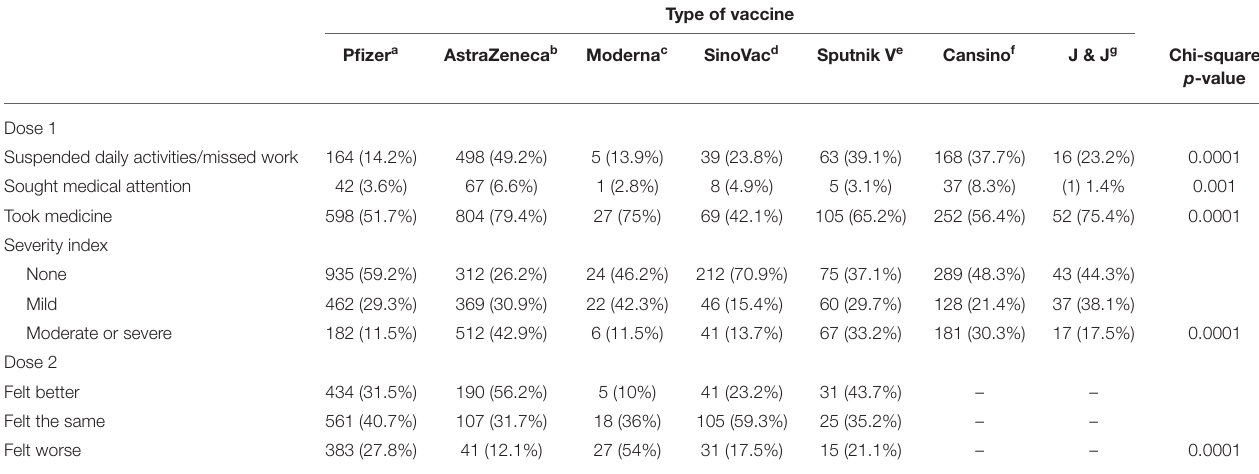
TABLE 4 | The severity of side effects by the number of dose and type of